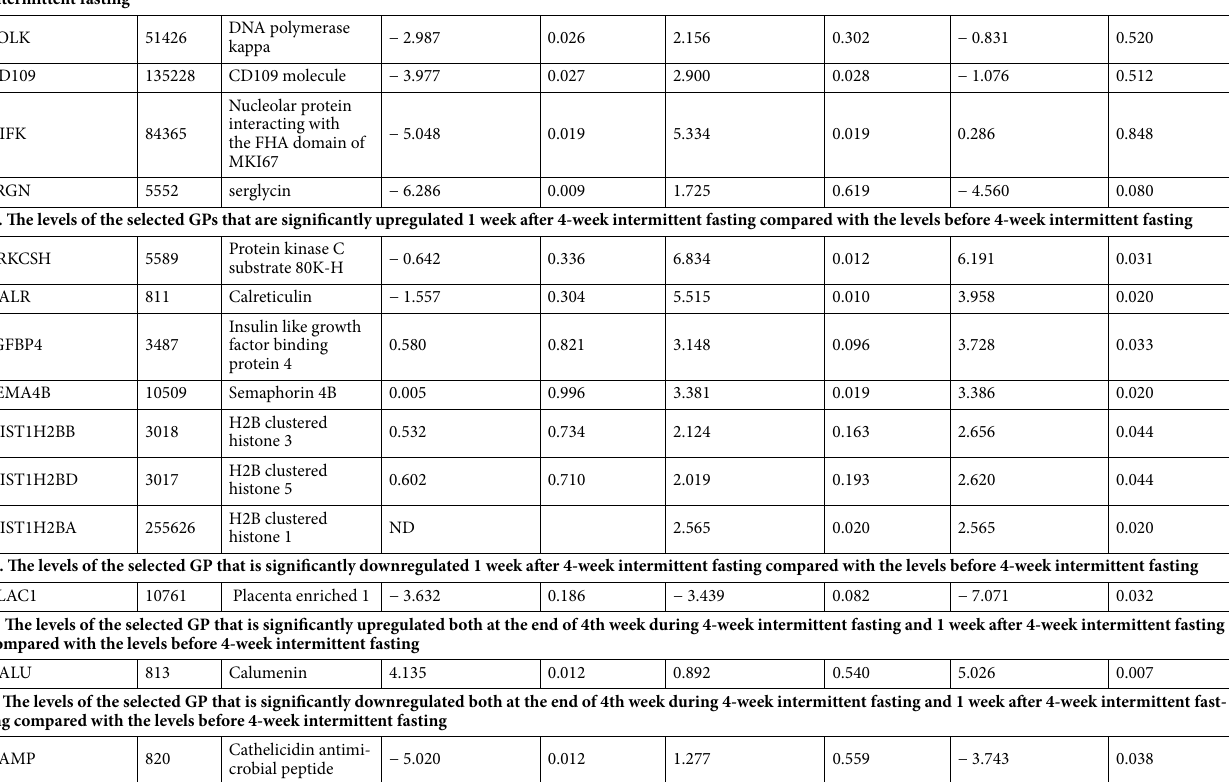
Table 2. The effect of 4-week intermittent fasting from dawn to sunset on selected gene protein products (GPs) in subjects with metabolic syndrome. ND Not detected. a A positive average paired log2 fold change indicates an increase and negative average paired log2 fold change indicates a decrease in the levels measured at the end of 4th week during 4-week intermittent fasting compared with the levels measured before 4-week intermittent fasting. b A positive average paired log2 fold change indicates an increase and negative average paired log2 fold change indicates a decrease in the levels measured 1 week after 4-week intermittent fasting compared with the levels measured at the end of 4th week during 4-week intermittent fasting. c A positive average paired log2 fold change indicates an increase and negative average paired log2 fold change indicates a decrease in the levels measured 1 week after 4-week intermittent fasting compared with the levels measured before 4-week intermittent